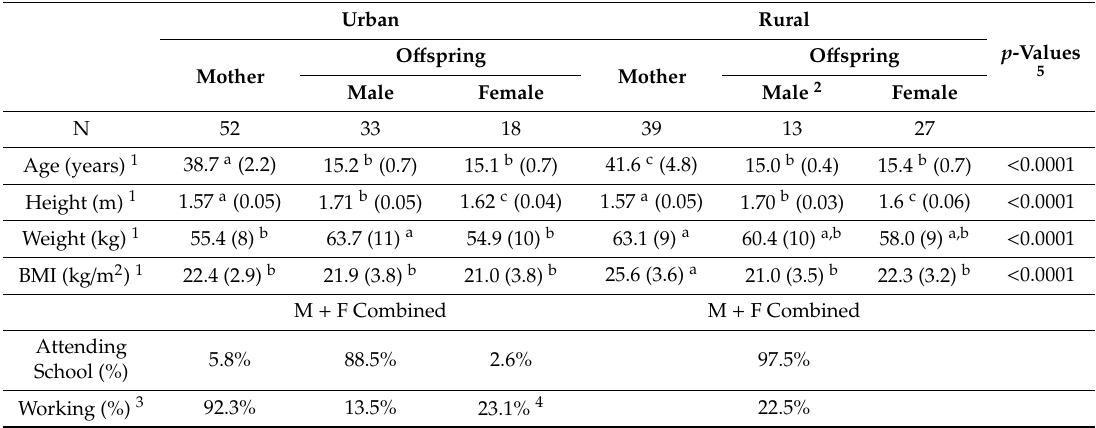
Table 1. Participant characteristics. Further details are available